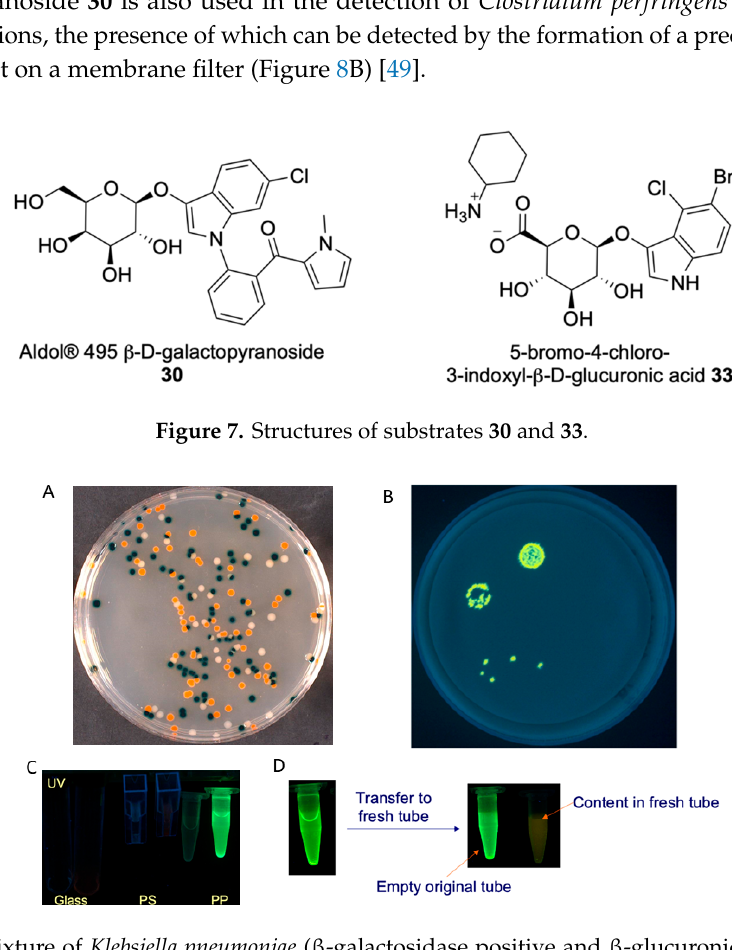
Figure 8. Mixture of Klebsiella pneumoniae ( β -galactosidase positive and β -glucuronidase negative, orange colour), E. coli ( β -galactosidase positive and β -glucuronidase positive, dark-violet colour), and Salmonella enteritidis (negative for both enzymatic activities, uncoloured) on a single plate after 24 h of incubation ( A ). Detection on membrane filter of Clostridium perfringens cultivated under anaerobic conditions by using Aldol ® 495 β -D-galactopyranoside 30 ( B ). Fluorescent emission of a solution containing Aldol ® 495 in a Polypropylene (PP) tube ( C ) and of the PP tube once emptied ( D ). Pictures kindly supplied by Dr Julian Ihssen, Biosynth Carbosynth.